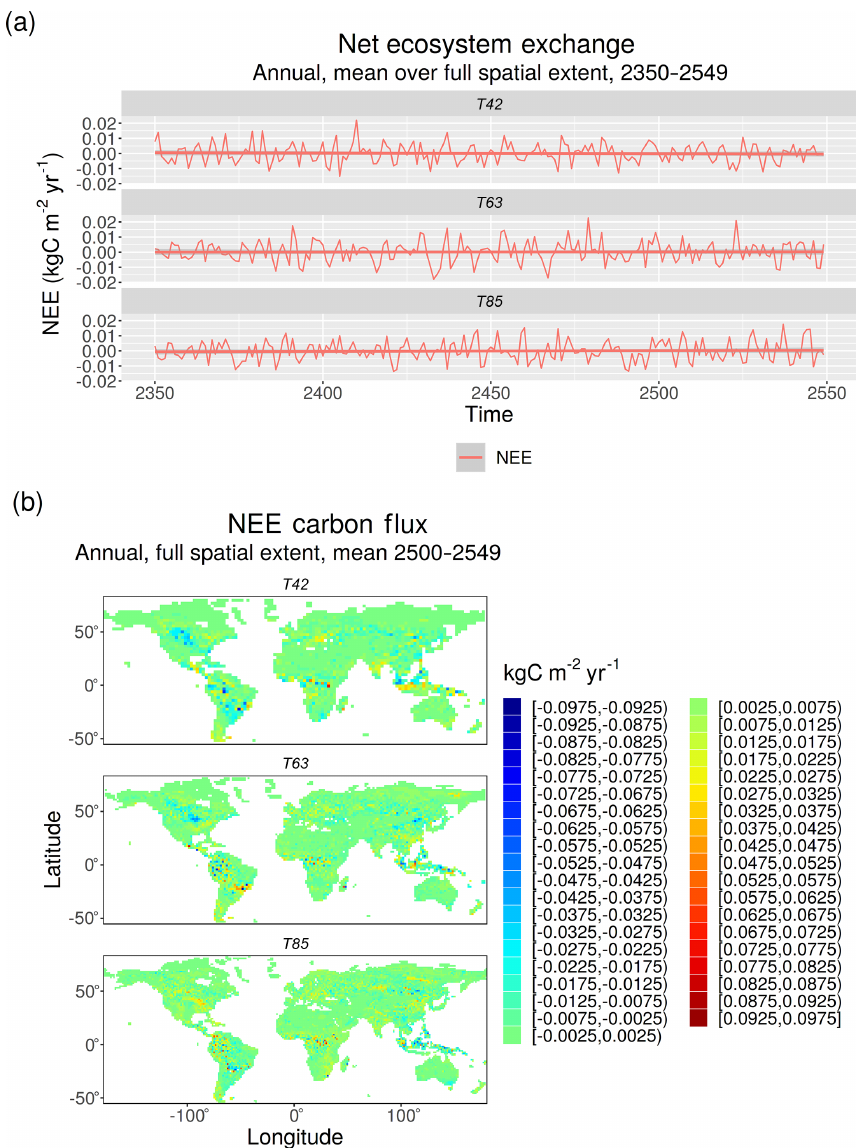
Figure B1. Net ecosystem exchange (NEE) for all EMAC simulations (a) averaged globally and plotted for the last 200 years of the simulation and (b) averaged over the last 50 years of the simulation and plotted globally. The straight red lines with grey uncertainty bands in panel (a) are linear fits to the